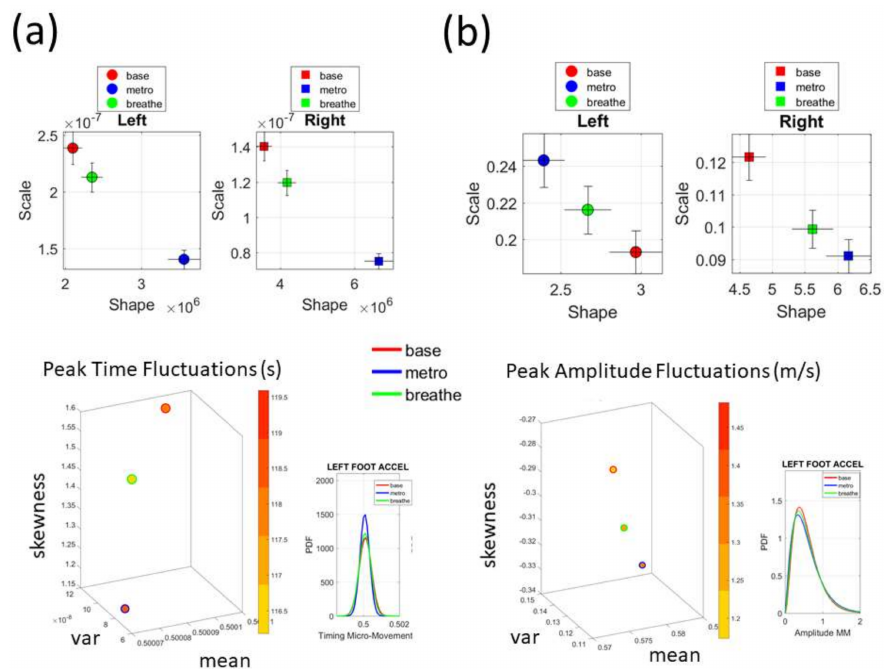
Figure 11. Comparison of subtle changes in walking patterns with task demands and levels of autonomous control using accelerometer data from the Zeblok smart shoes. ( a ) Stochastic signatures on the Gamma parameter plane and Gamma moments space for fluctuations in peak timing and ( b ) fluctuations in peak